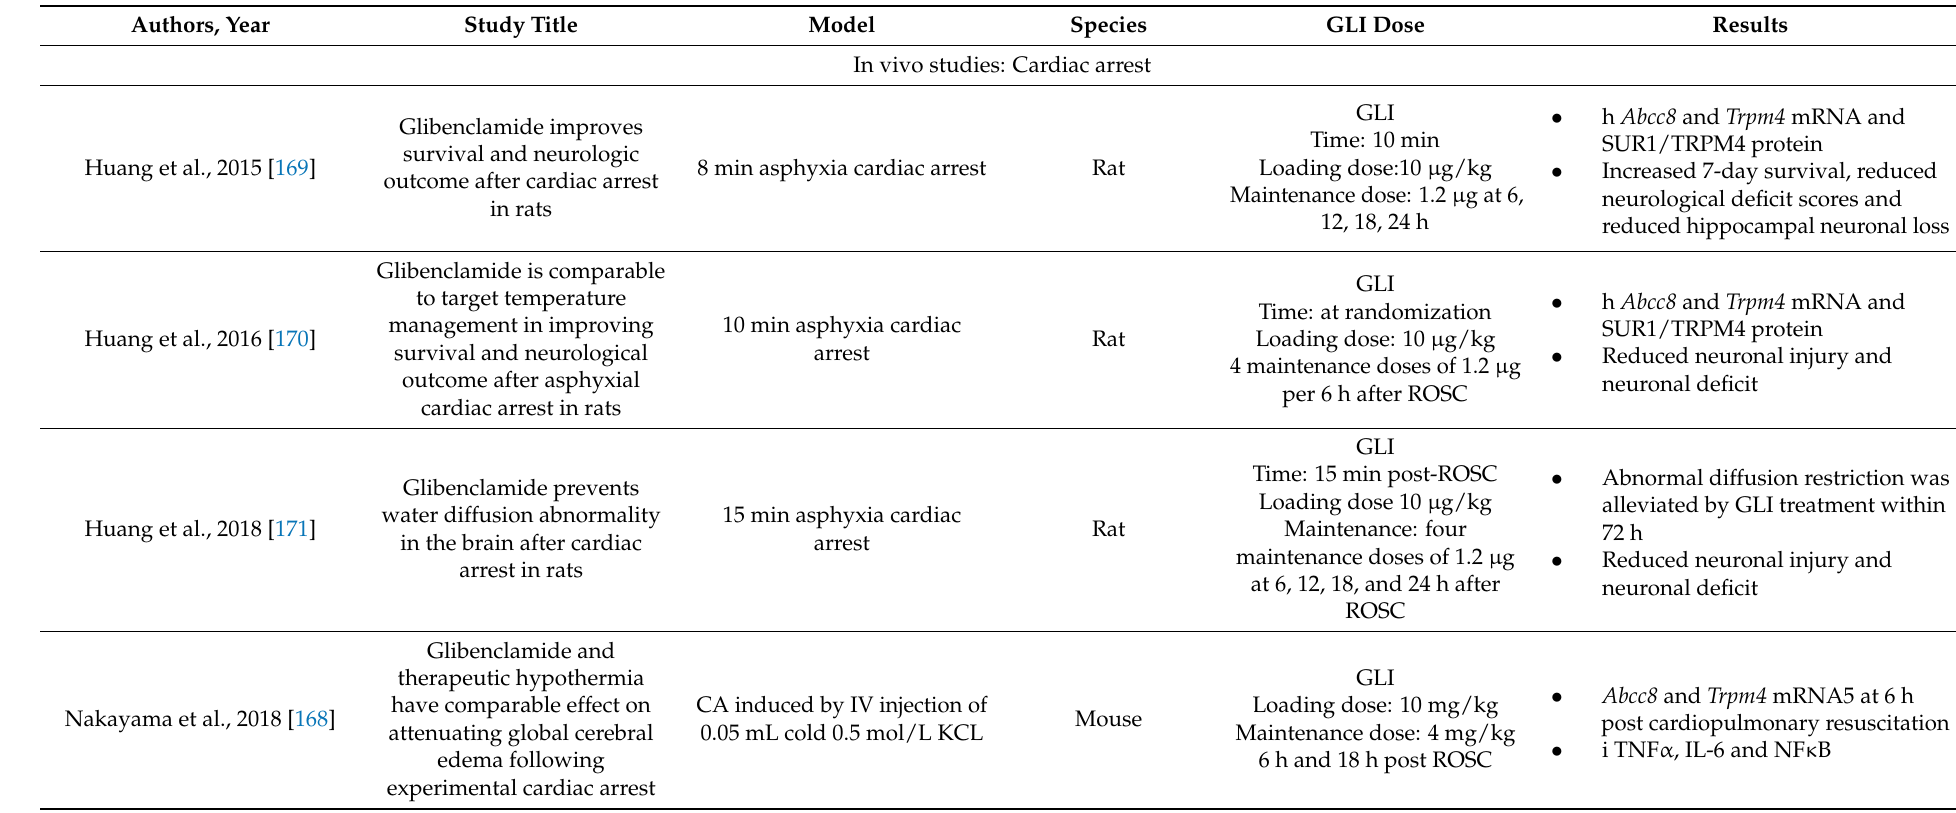
Table 7. Pre-clinical and clinical studies evaluating SUR1 inhibition for other neurological